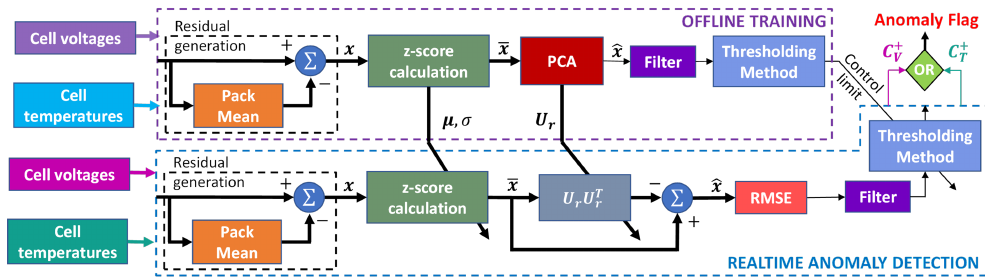
Figure 1. Block diagram of proposed PCA-based anomaly detection algorithm (PCA